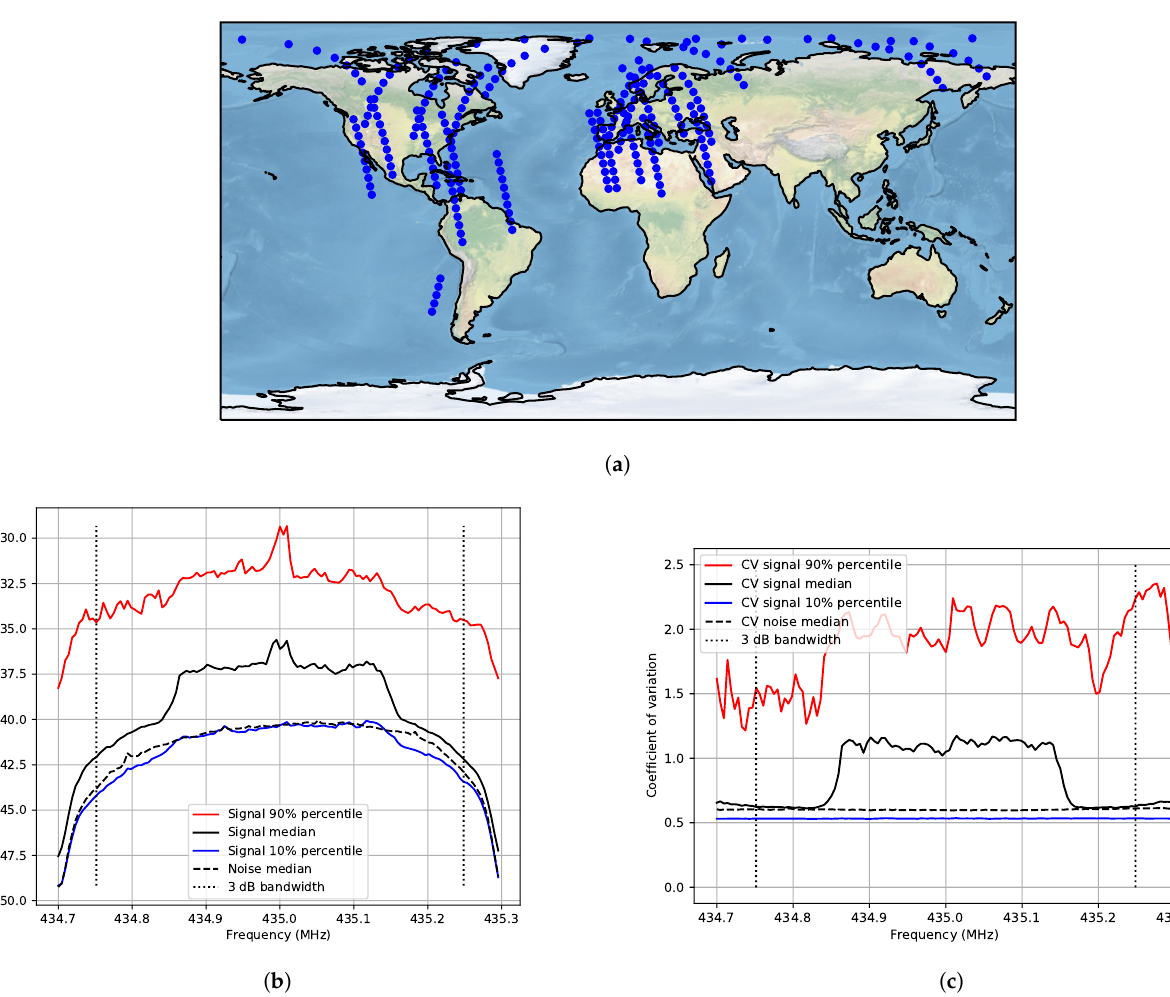
Figure 8. Time-frequency behaviour of measurements over populated areas. ( a ) Sub-satellite points for measurements over populated areas. ( b ) Spectrum of average power ( m 2 k ). ( c ) CV. A high CV indicates high spread in the measured